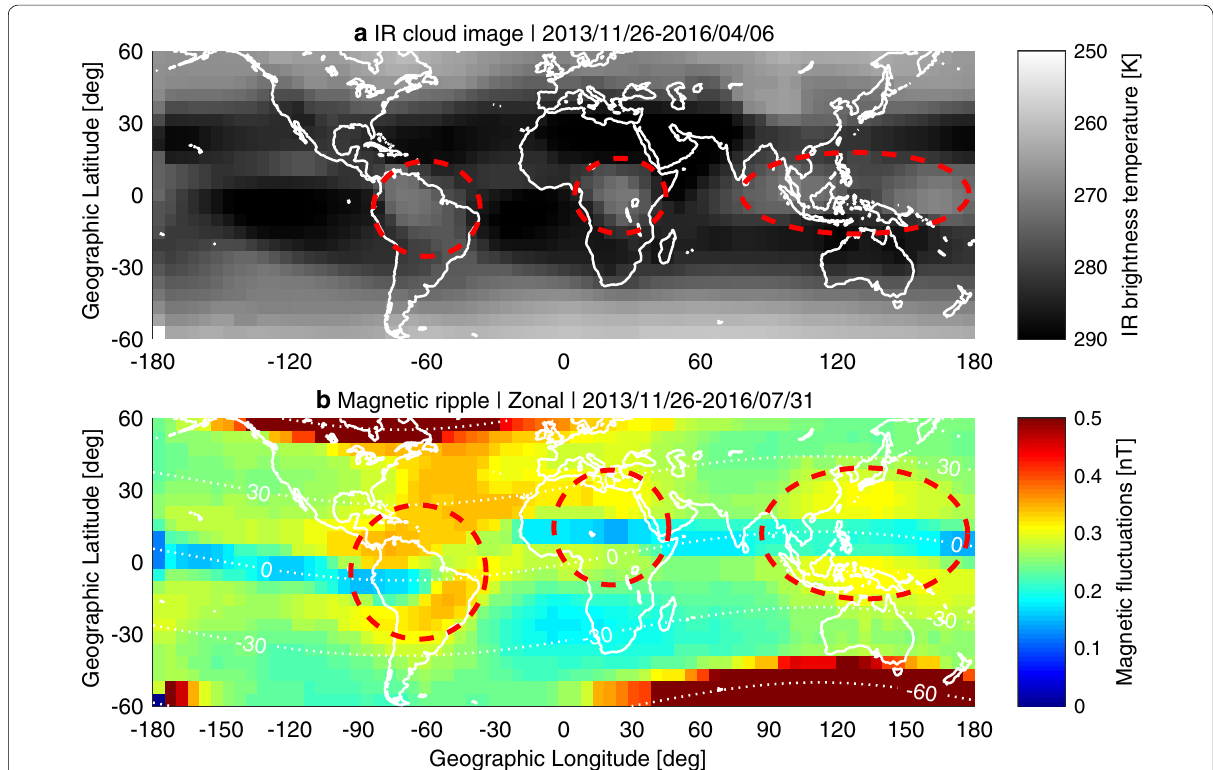
Fig. 15 Comparison between IR cloud image and global distribution of average MR amplitudes. Global distribution of the average infrared bright- ness temperature ( top ) and MR amplitudes of the zonal component observed by all three Swarm satellites ( bottom ) on the entire LT sector within the period from November 26, 2013, to April 4, 2016 ( top ) and from November 26, 2013, to July 31, 2016 ( bottom ). The red dotted circles indicate the bright area in each